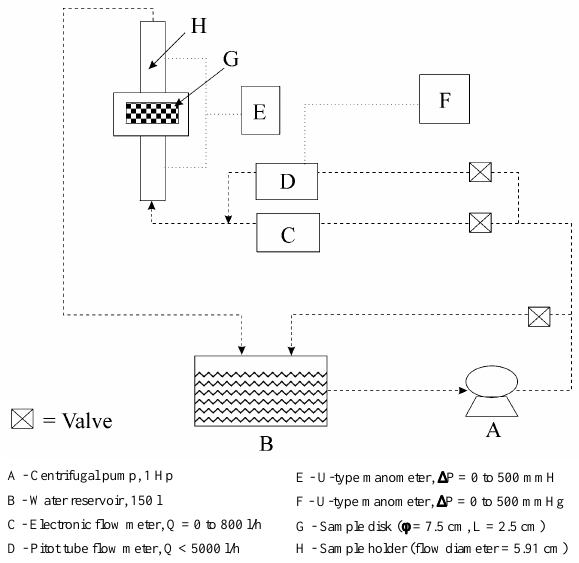
Figure 1. Apparatus for experimental determination of ceramic foam permeability to water